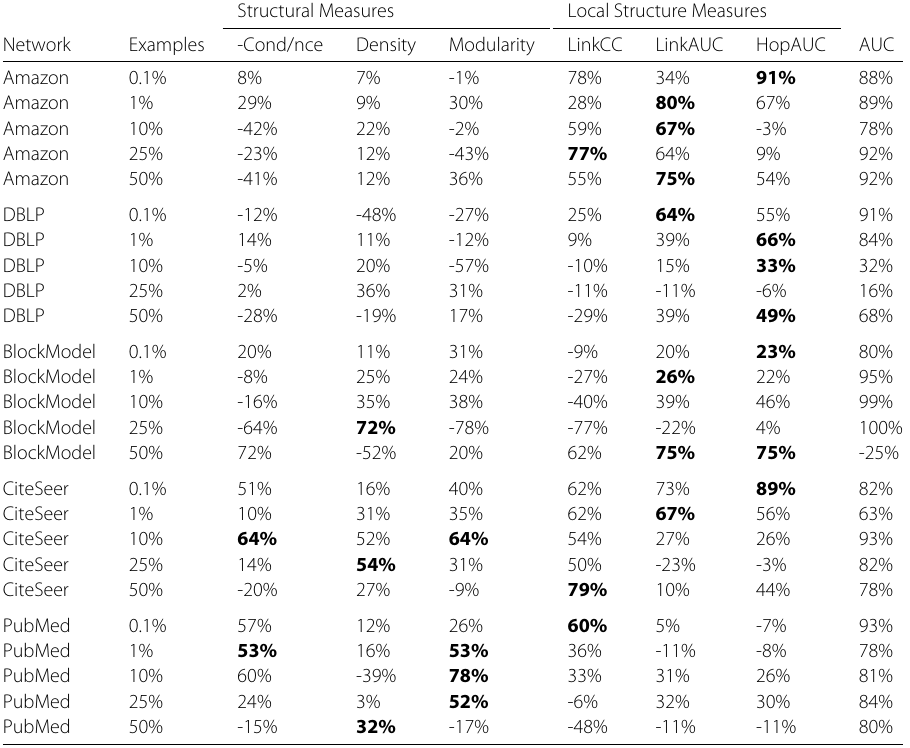
Table 4 Spearman correlation between other measures and NDCG Structural Measures Local Structure